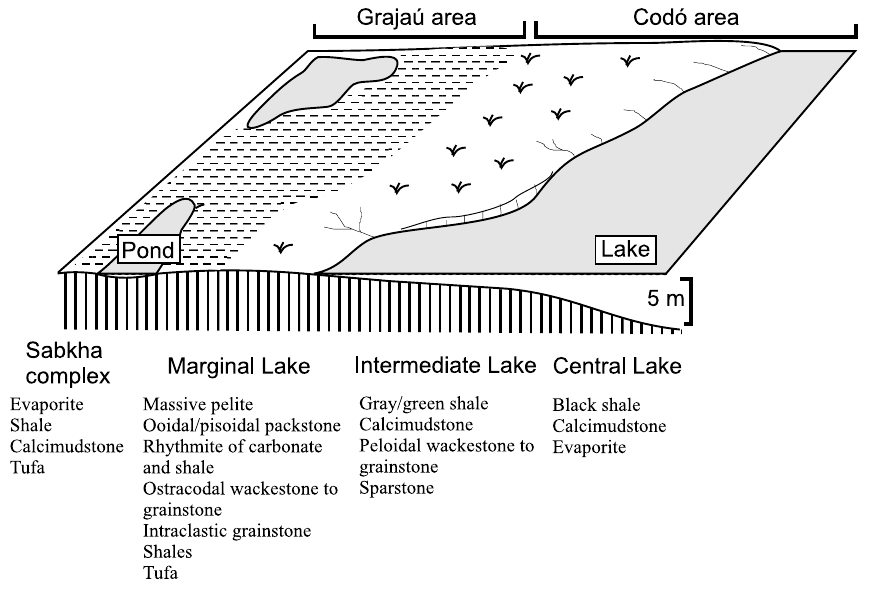
Fig. 3 – Depositional model proposed for the Codó Formation in the Codó and Grajaú areas (cf. Paz and Rossetti